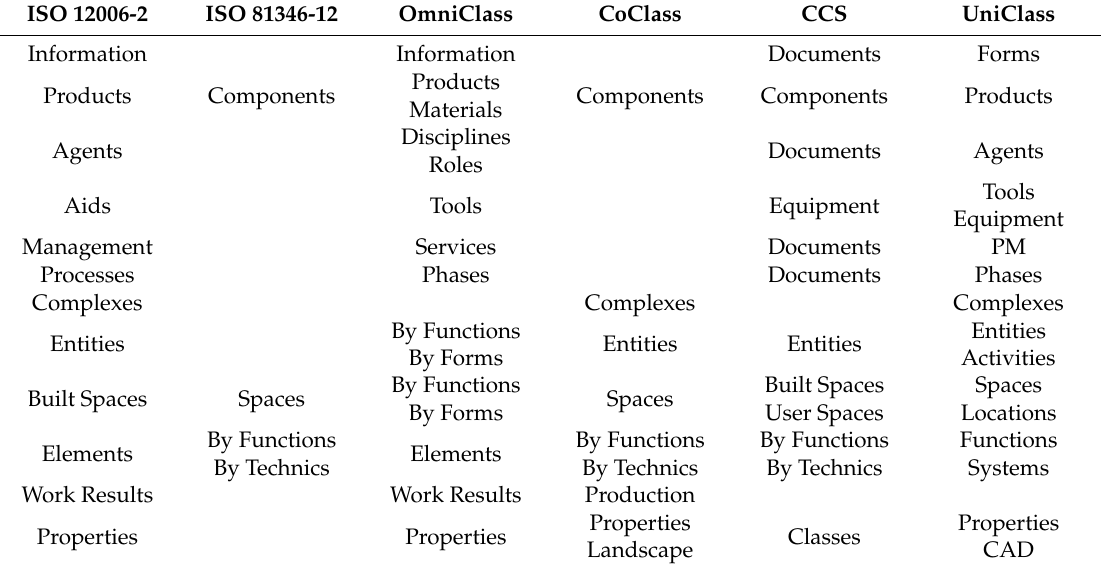
Table 4. Comparison of international coding systems.